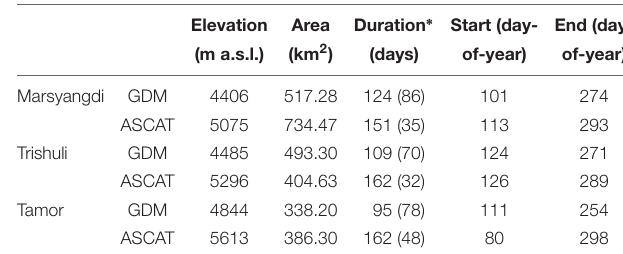
TABLE 5 | Averaged statistics for glacier melting occurrences during years